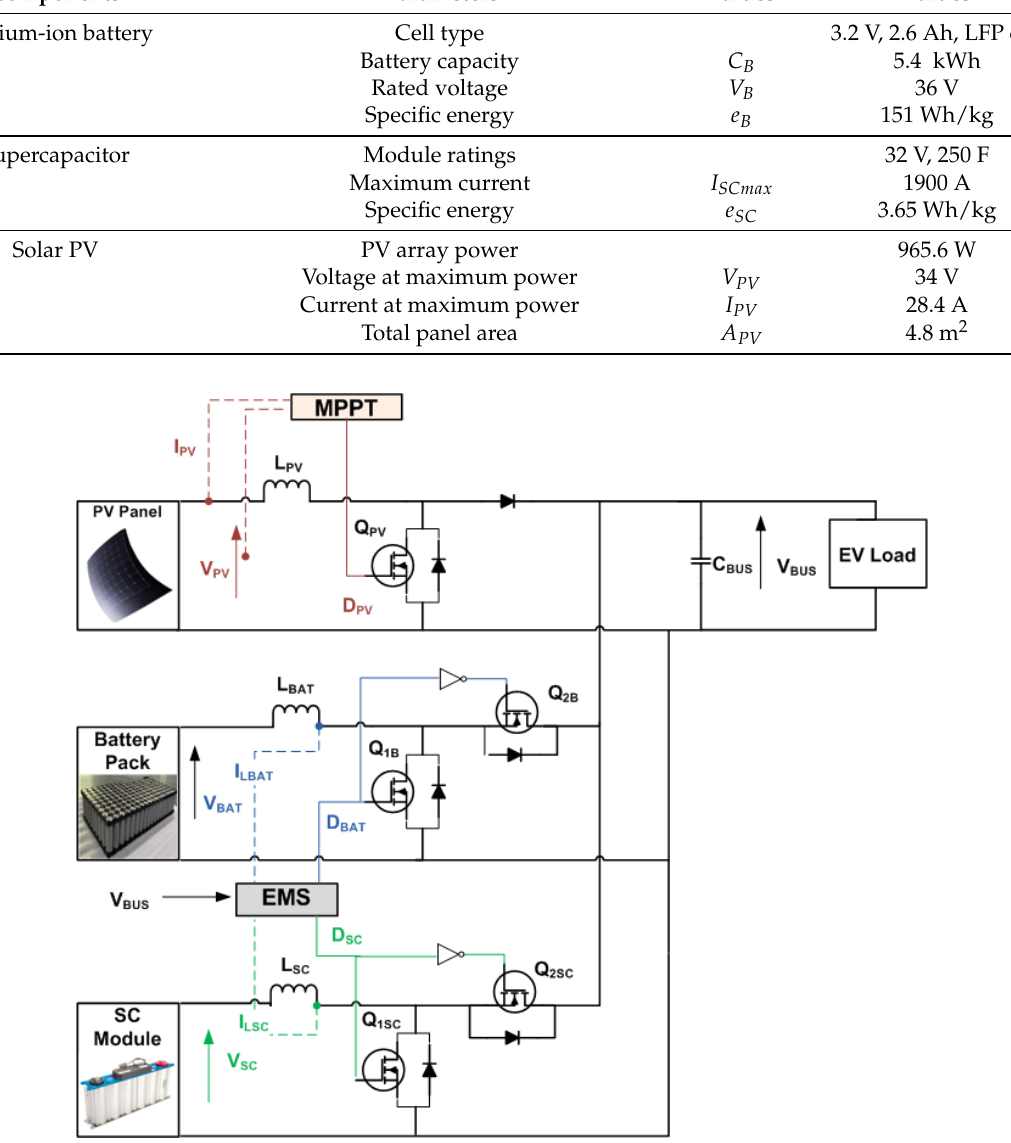
Figure 5. Circuit diagram of proposed EMS of hybrid-source electric